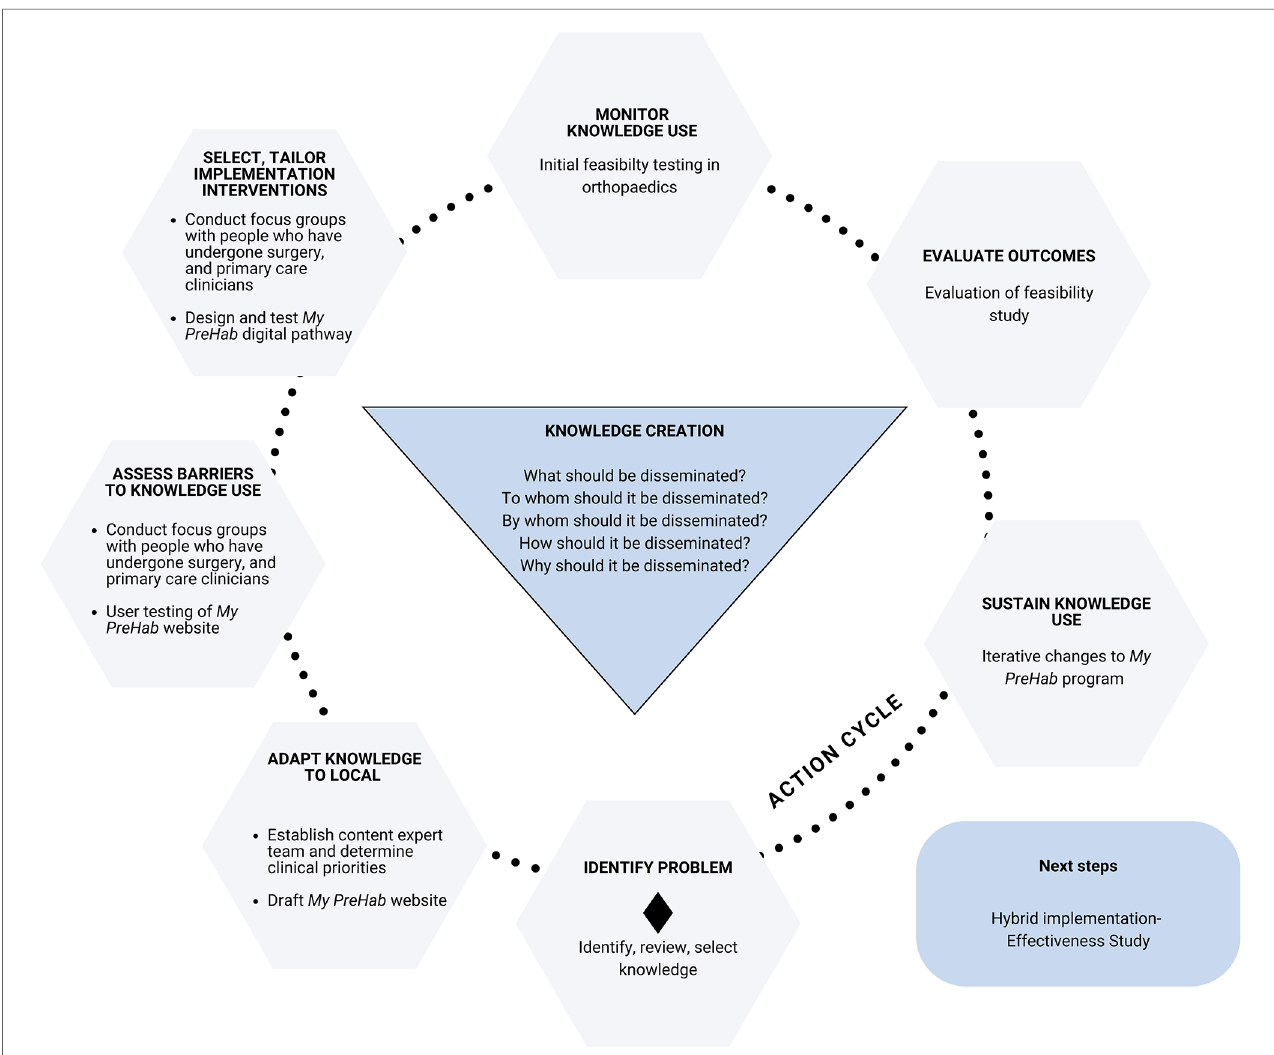
FIGURE 3 Use of the KTA framework (15) to guide the development and implementation of the My PreHab Program